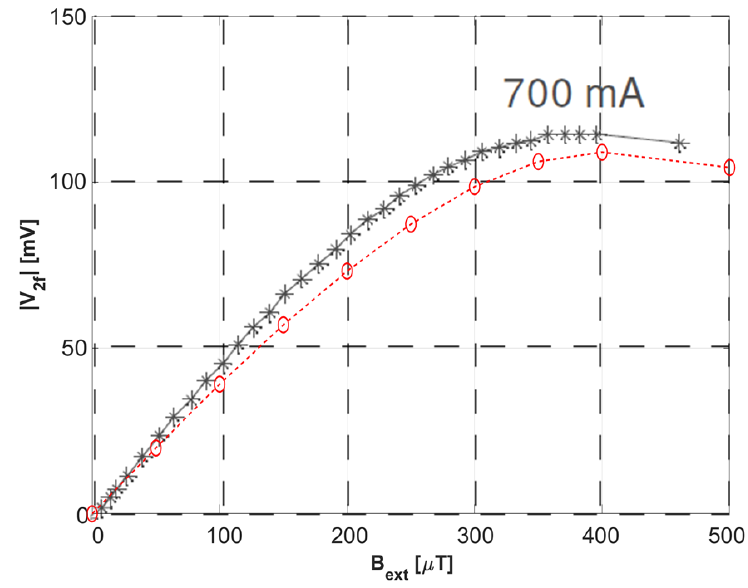
Figure 12. Second harmonic of the calculated differential output voltage plotted against the related external magnetic field (dashed red line and circles), overlapped to the experimental results from Figure 14 in [33] Copyright 2022 IEEE Transactions on Instrumentation and